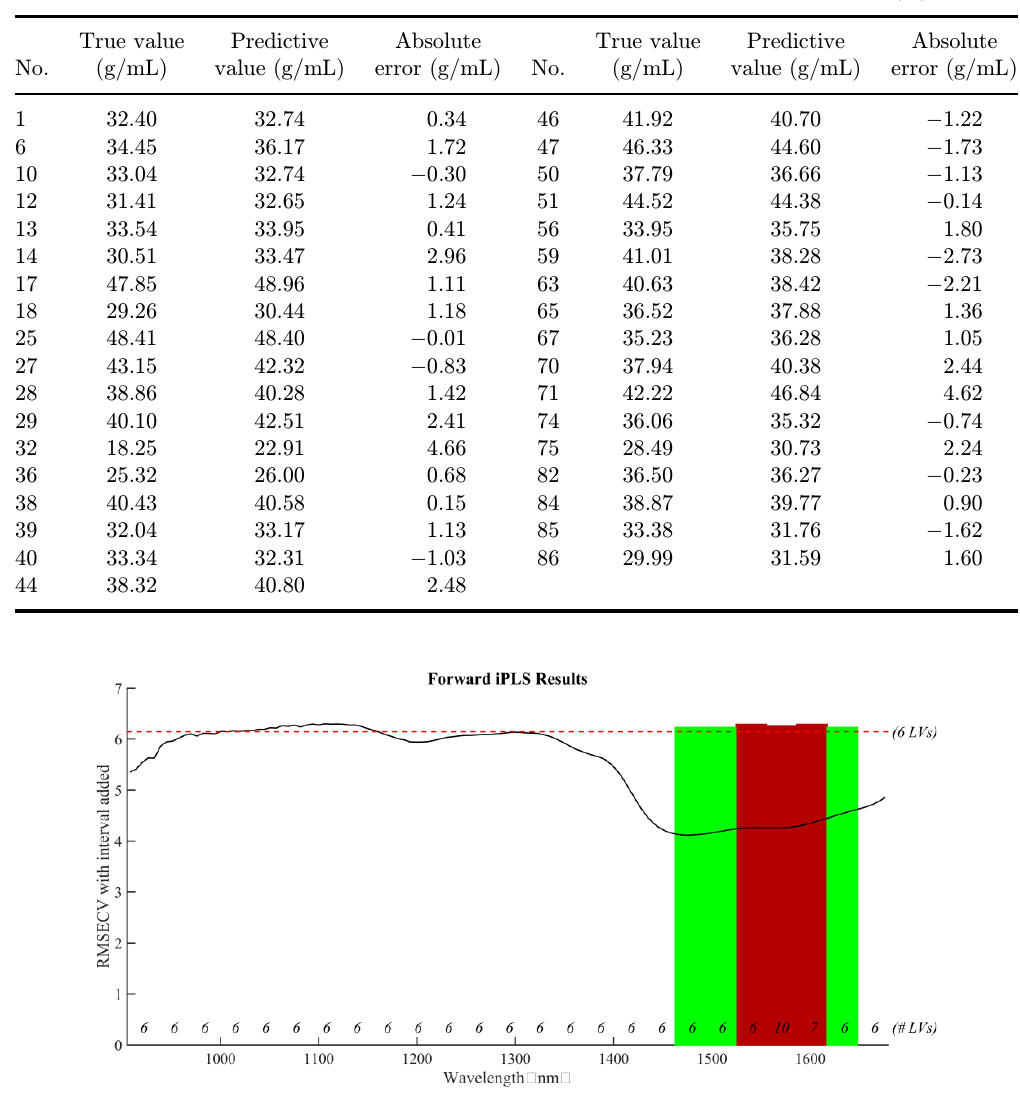
Table 7. Results of validation set predicted by optimal PLS quantitative model (%).